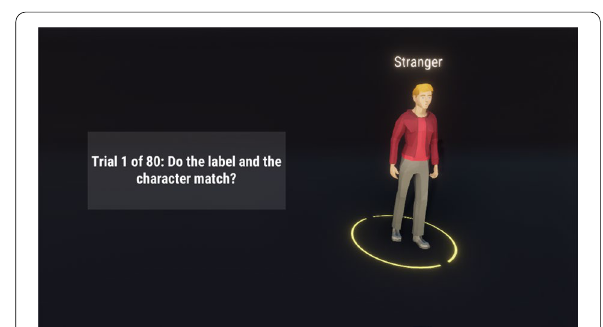
Fig. 6 Matching Task. Each trial the participants were presented with one of the two possible avatars and a label that may or may not correspond with the depicted avatar. In this case, based on Fig. 3, the avatar depicted and the label